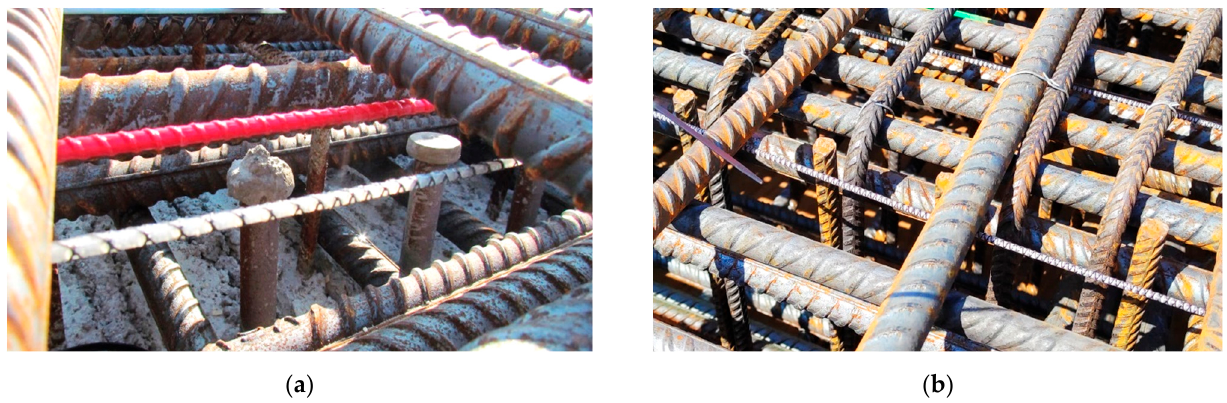
Figure 30. Installation of flexible monolithic DFOS sensors by tying them to the existing reinforcement in two German bridges: ( a ) near the city of Sande; ( b ) near the Frankfurt am Main.